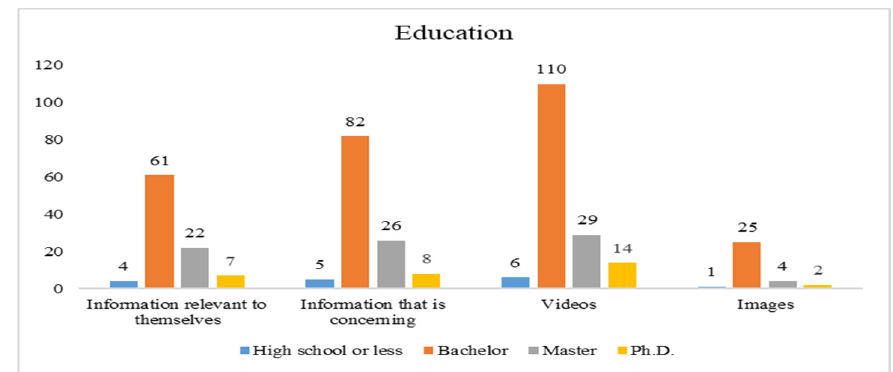
Figure 4. Educational distribution of the study respondents.